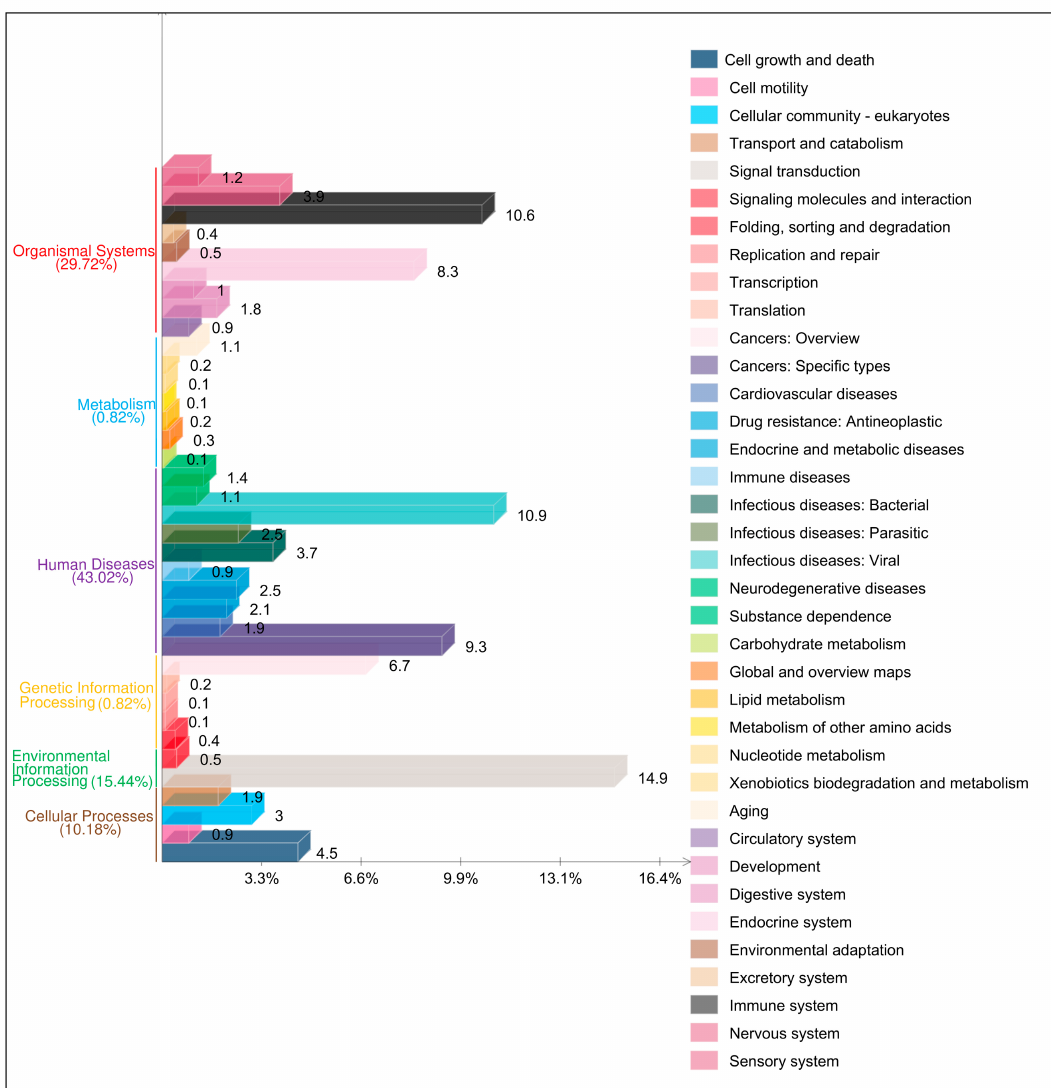
Figure 5. A bar plot of the KEGG pathways of the human innate immunity-related proteins, which are interacting with the core proteins of the 56 PHBifs. The pathway legends corresponding to the bars (from bottom to top) are given on the right